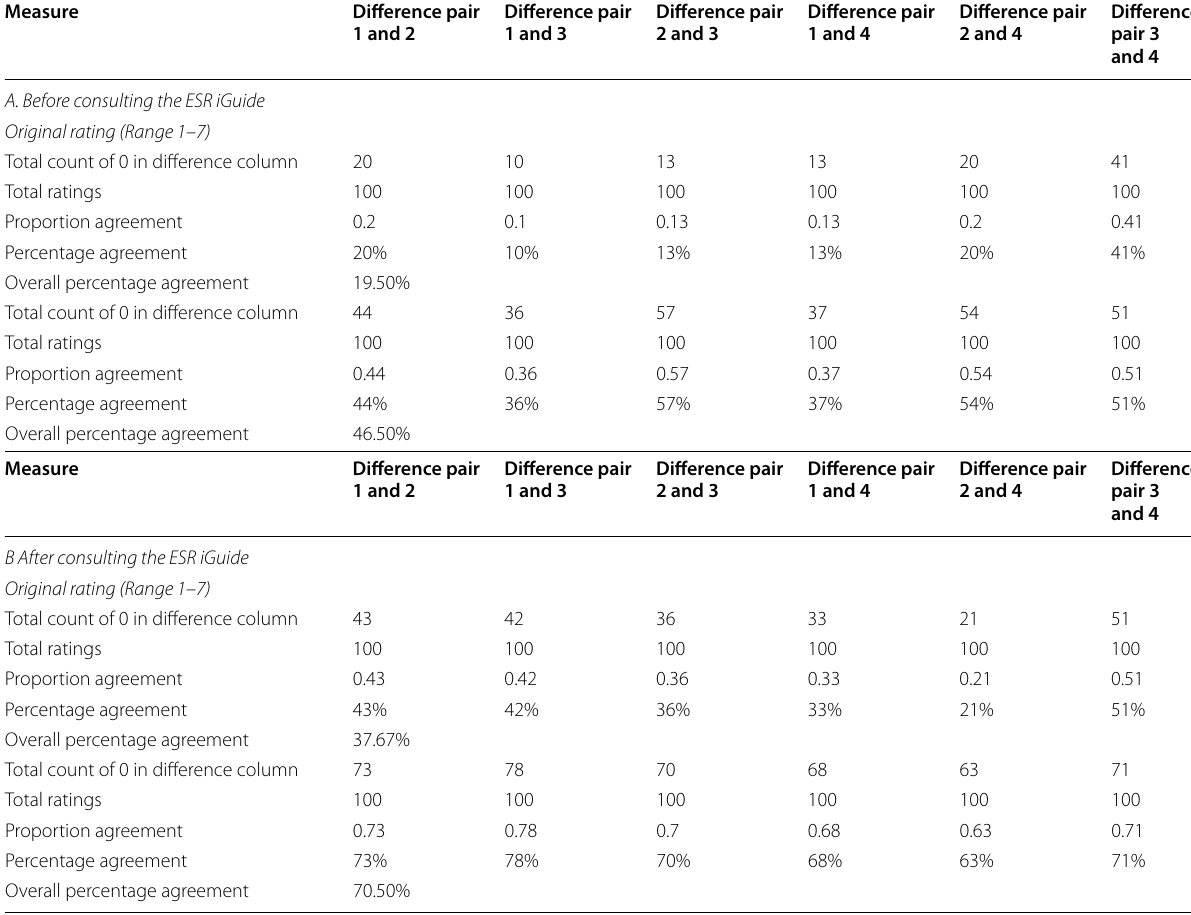
Table 5 Overall percentage agreement (ID expert: 1,2- radiology, 3,4- Emergency Department Physician) before and after